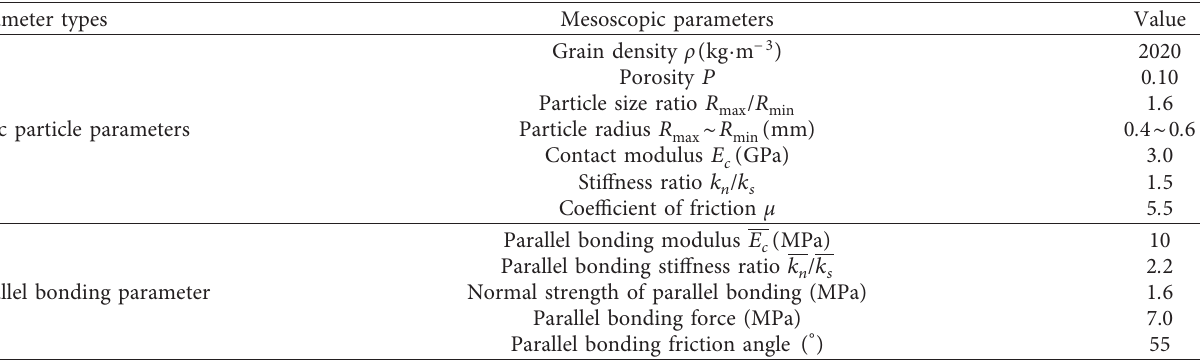
Table 2: Particle microscopic parameters.